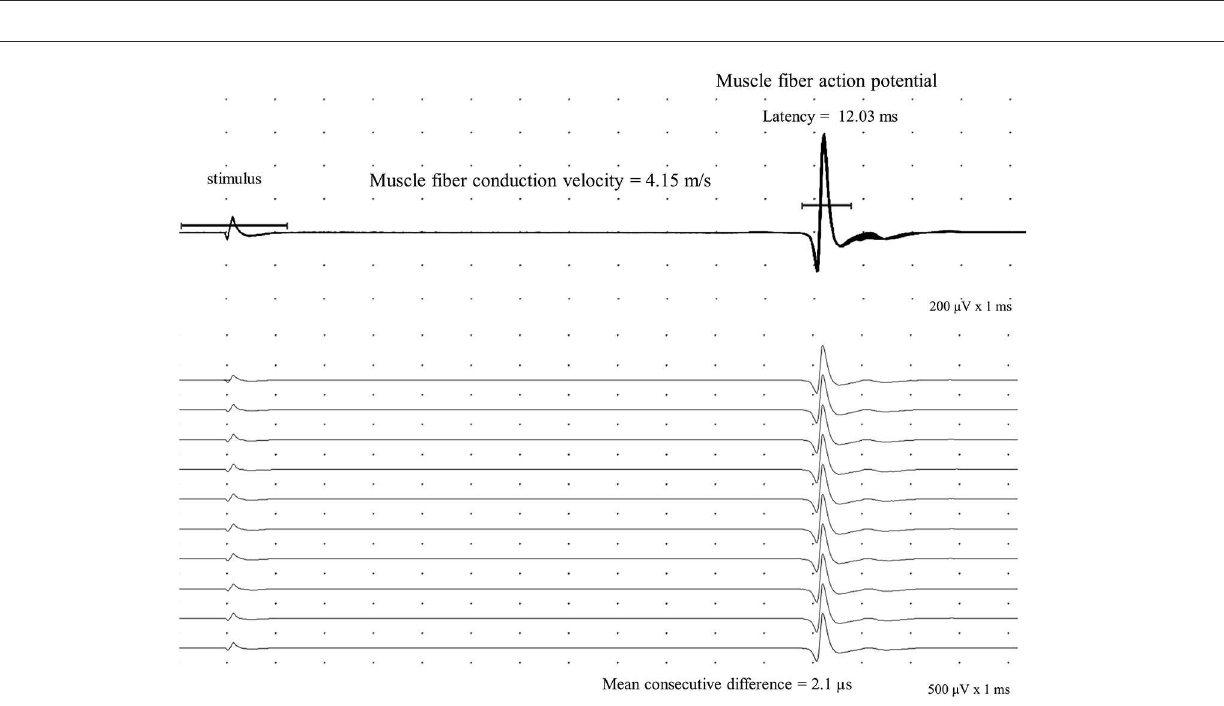
FIGURE4 Direct muscle fiber action potential (MFAP) is recorded in the tibialis anterior with a concentric needle electrode after an intramuscular monopolar needle electrical stimulation at 10Hz with a 50mm distance. The mean consecutive difference with a 2.1 µ s value in a sequence of a hundred potentials (shown 10) defines a direct muscle activation. The calculated muscle fiber conduction velocity is 4.15